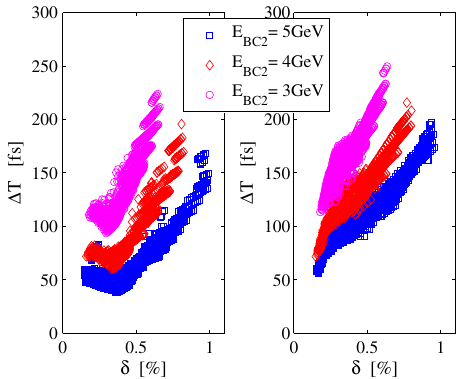
FIG. 7. Working points for different beam energy of BC2. The tail bunch is under (left) and over (right) compression, respec- tively. The peak current requirement is 3 – 5 kA of the core beam.